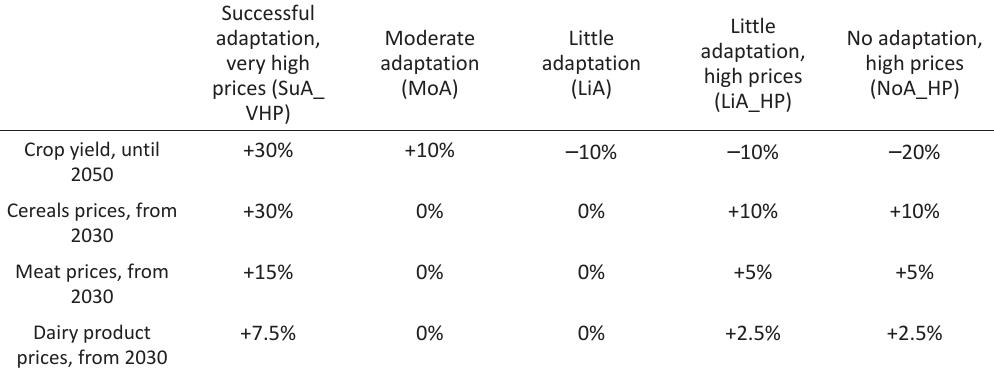
Table 1. Yield and price -scenario specifications for years 2014–2050, compared to the